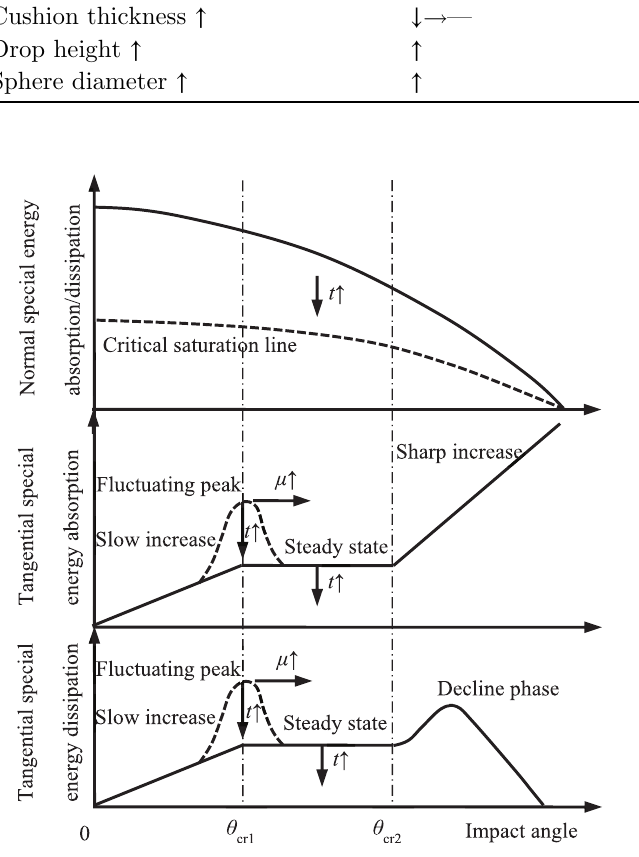
Fig. 6. Change laws of special energy